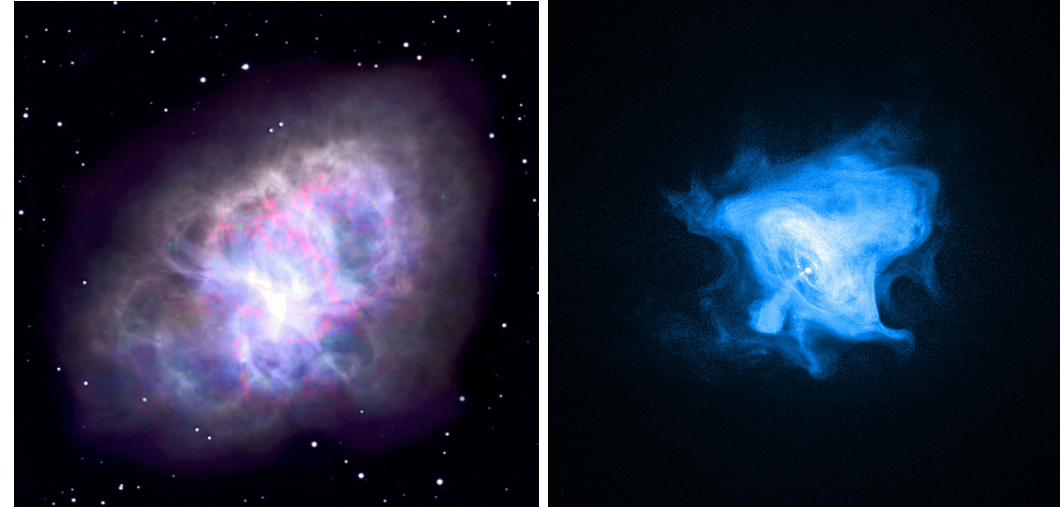
Figure 2. Left panel: The Crab nebula as seen in radio with the National Radio Astronomy Observatory (credits: M. Bietenholz, T. Burchell NRAO/AUI/NSF; B. Schoening/NOAO/AURA/NSF). Right panel: The Crab nebula in X-rays, as seen by Chandra (credits: Chandra X-ray Observatory NASA/CXC/SAO/F.Seward et